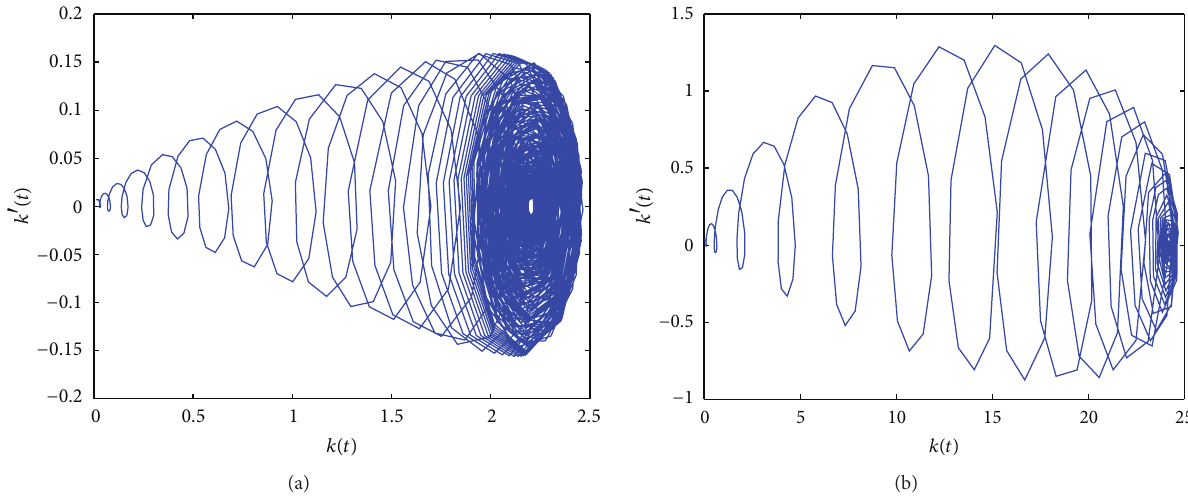
Figure 4: The time evolution of 𝑘 󸀠 (𝑡) versus 𝑘(𝑡) for 𝑠 = 0.41 , 𝛿 = 0.35 , 𝛼 = 0.8 , 𝐴 = 1 , 𝜏 1 = 10 , 𝜏 2 = 2 , and 𝑡 ∈ [0, 3500] (a). The time evolution of 𝑘 󸀠 (𝑡) versus 𝑘(𝑡) for 𝑠 = 0.91 , 𝛿 = 0.35 , 𝛼 = 0.8 , 𝐴 = 1 , 𝜏 1 = 10 , 𝜏 2 = 2 , and 𝑡 ∈ [0, 3500]